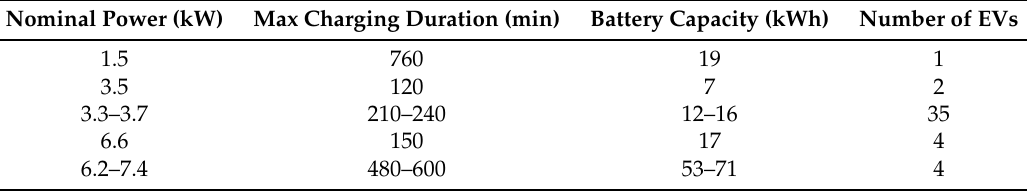
Table 1. Detected characteristics of electric vehicles